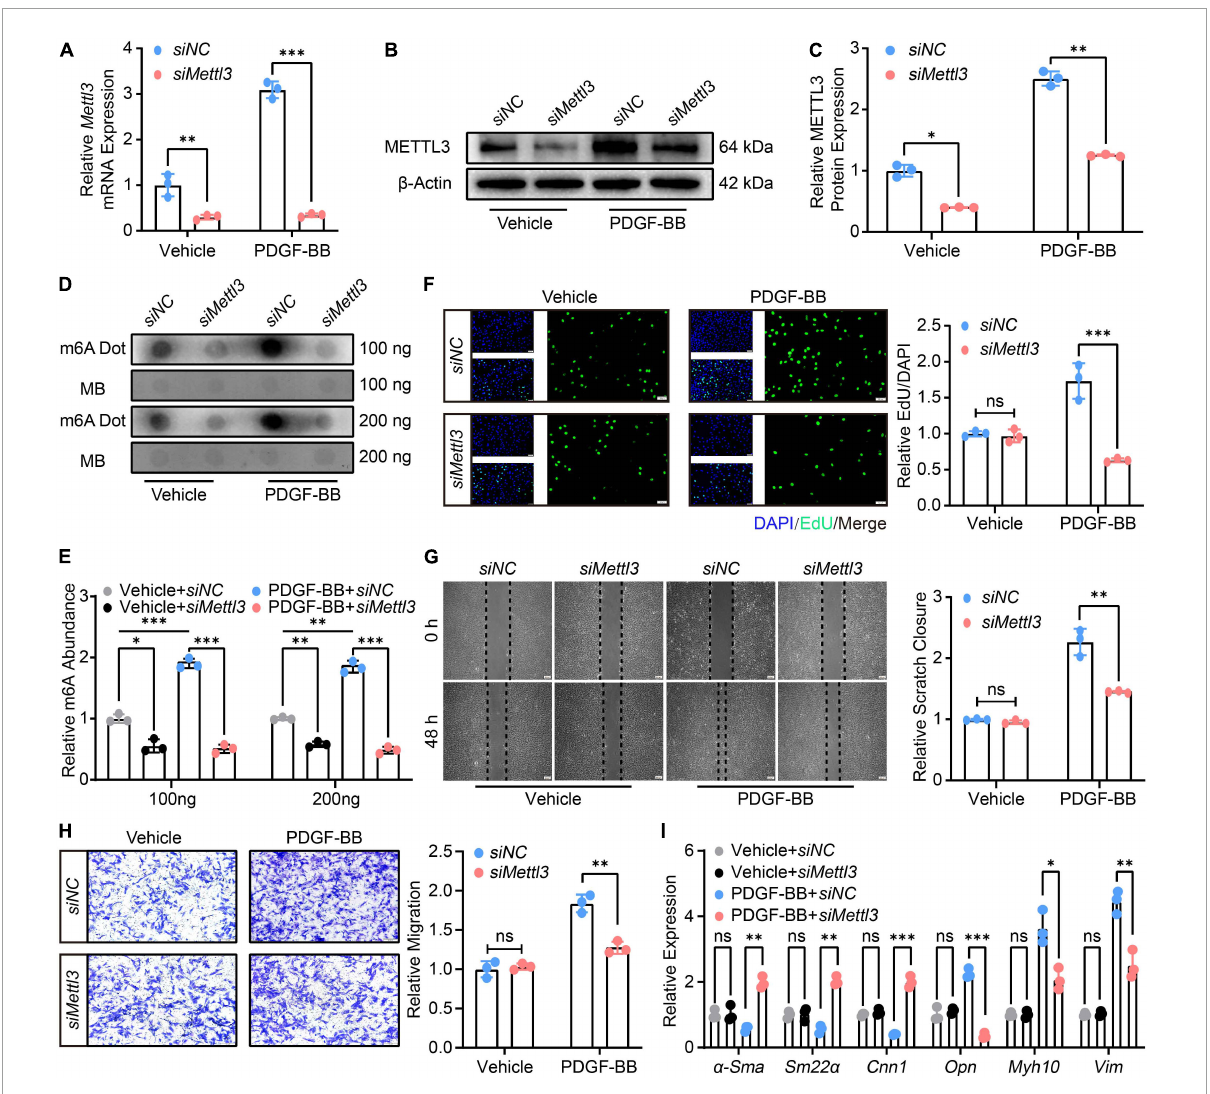
FIGURE3 Down-regulation of methyltransferase like 3 (METTL3) results in decreased N6-methylatidine (m6A) and prevents vascular smooth muscle cells (VSMCs) from phenotype switching. (A) Quantitative analysis of Mettl3 expression transfected with control siRNA ( siNC ) and siRNA target to Mettl3 ( siMettl3 ) upon PDGF-BB present or not. (B,C) Representative Western Blot image (B) and quantification data (C) showing METTL3 expression. (D,E) Representative Dot Blot image (D) and quantitative analysis (E) of m6A level. (F) Representative EdU images [(left panel), scale bar = 50 µ m] and quantification of VSMCs proliferation (right panel). Three randomly selected fields for each sample were acquired. (G) Representative scratch images [(left panel), scale bar = 200 µ m] and quantification of VSMCs migration (right panel). Three randomly selected fields for each sample were acquired. (H) Representative transwell images [(left panel), scale bar = 100 µ m] and quantification of VSMCs migration (right panel). Three randomly selected fields for each sample were acquired. (I) Quantitative RT-qPCR analysis of contractile genes α -Sma , Sm22 α , Cnn1 , and synthetic genes Opn , Myh10, and Vim expression. All data were from three independent biological replicates and presented as mean ± SD. ∗ p < 0.05, ∗∗ p < 0.01 and ∗∗∗ p < 0.001 and ns indicates no